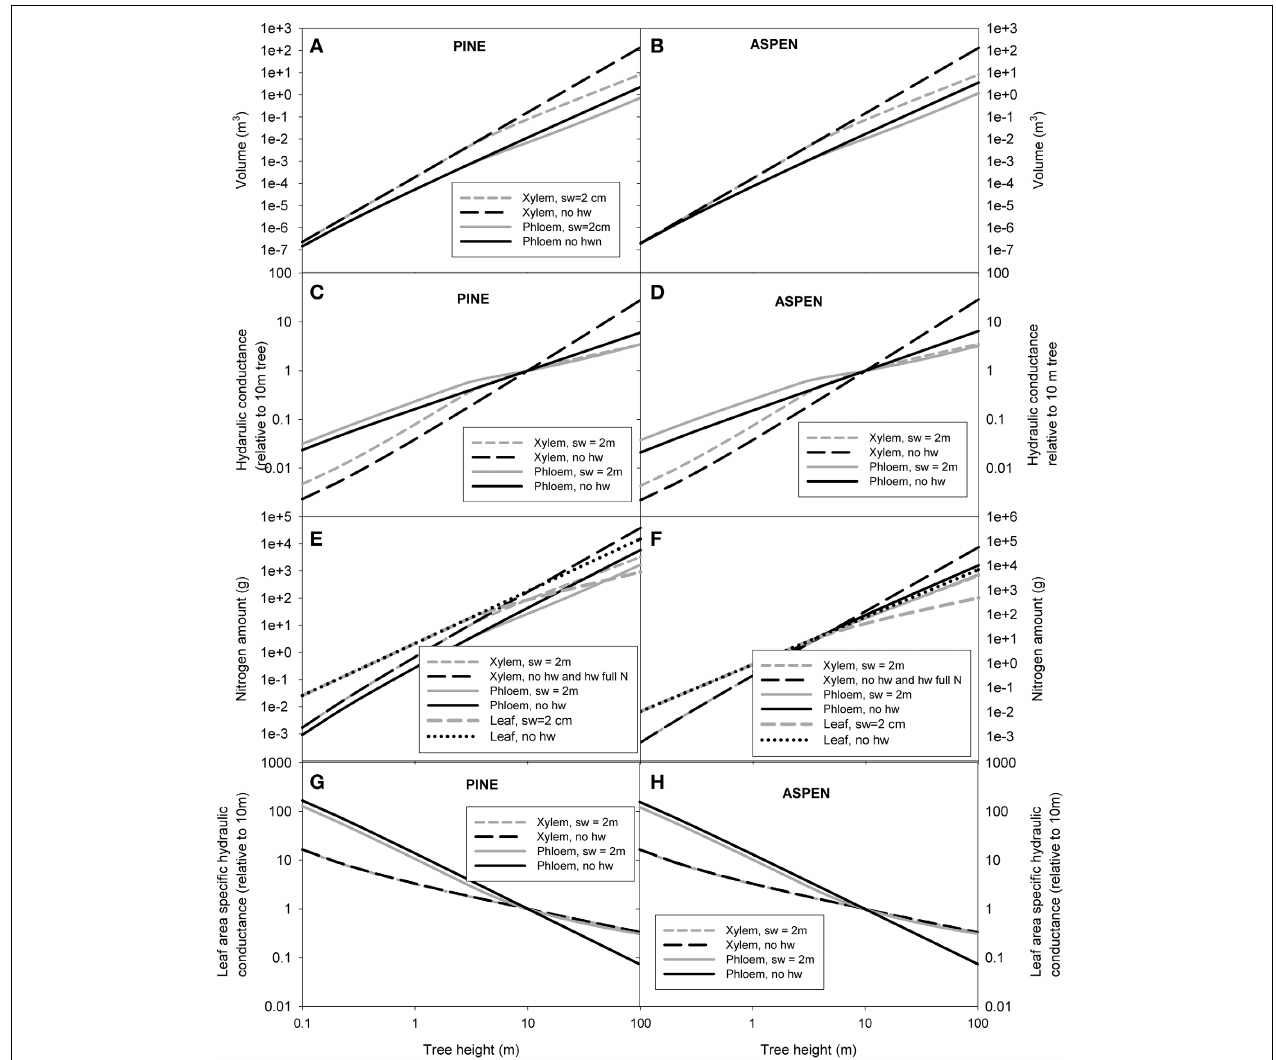
FIGURE 5 | The predictions for the absolute values for whole tree volume of xylem and phloem (A,B), hydraulic conductance of xylem and phloem (C,D), nitrogen content of xylem, phloem and leaves (E,F), and hydraulic conductance of xylem and phloem per leaf area (G,H) as a function of tree height. “sw = 2cm” refers to a scenario where maximum